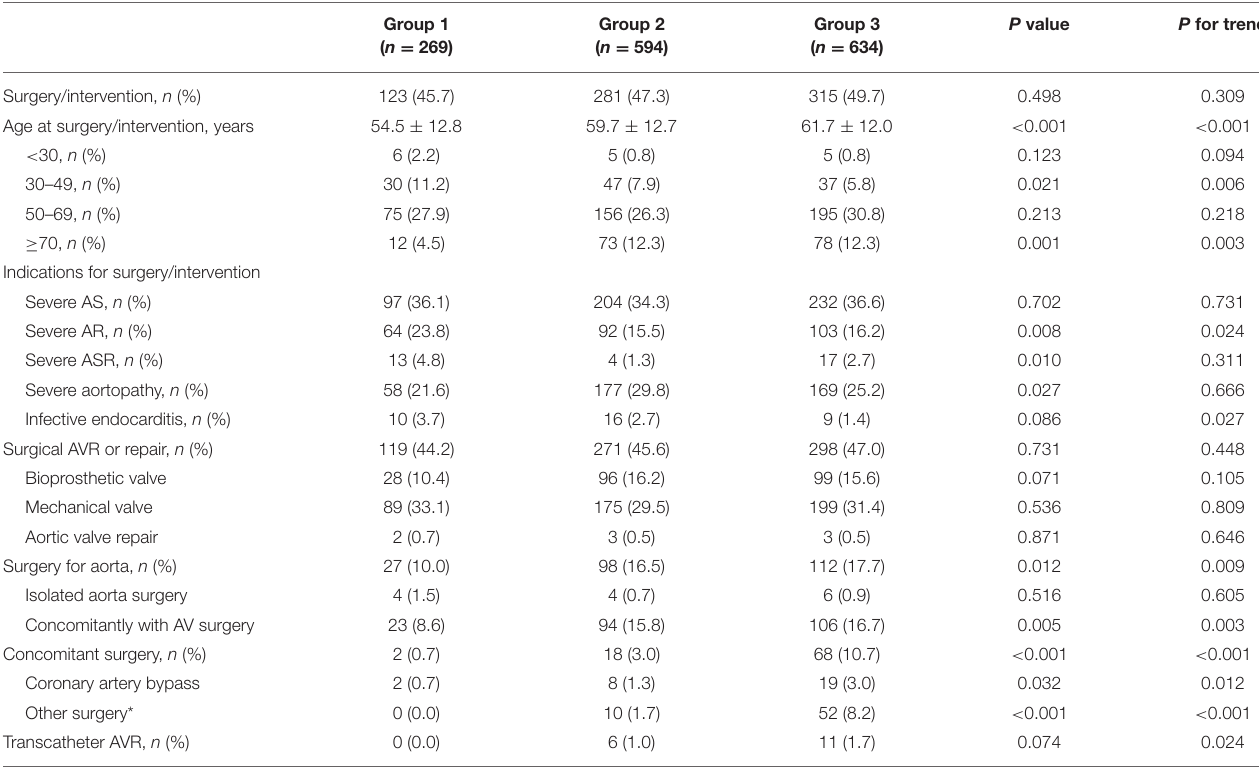
TABLE 2 | Treatment approaches in the three